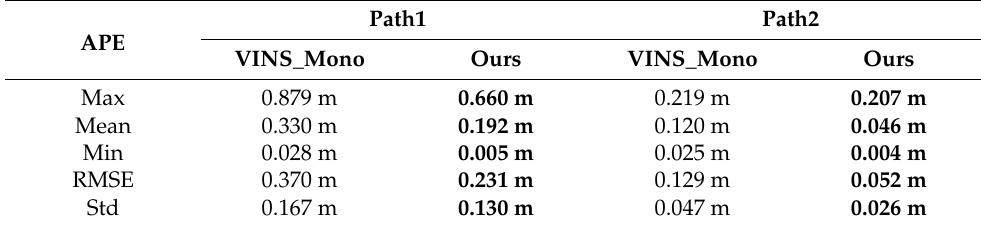
Figure 14. Trajectory error between the two algorithms and the true value under two paths.